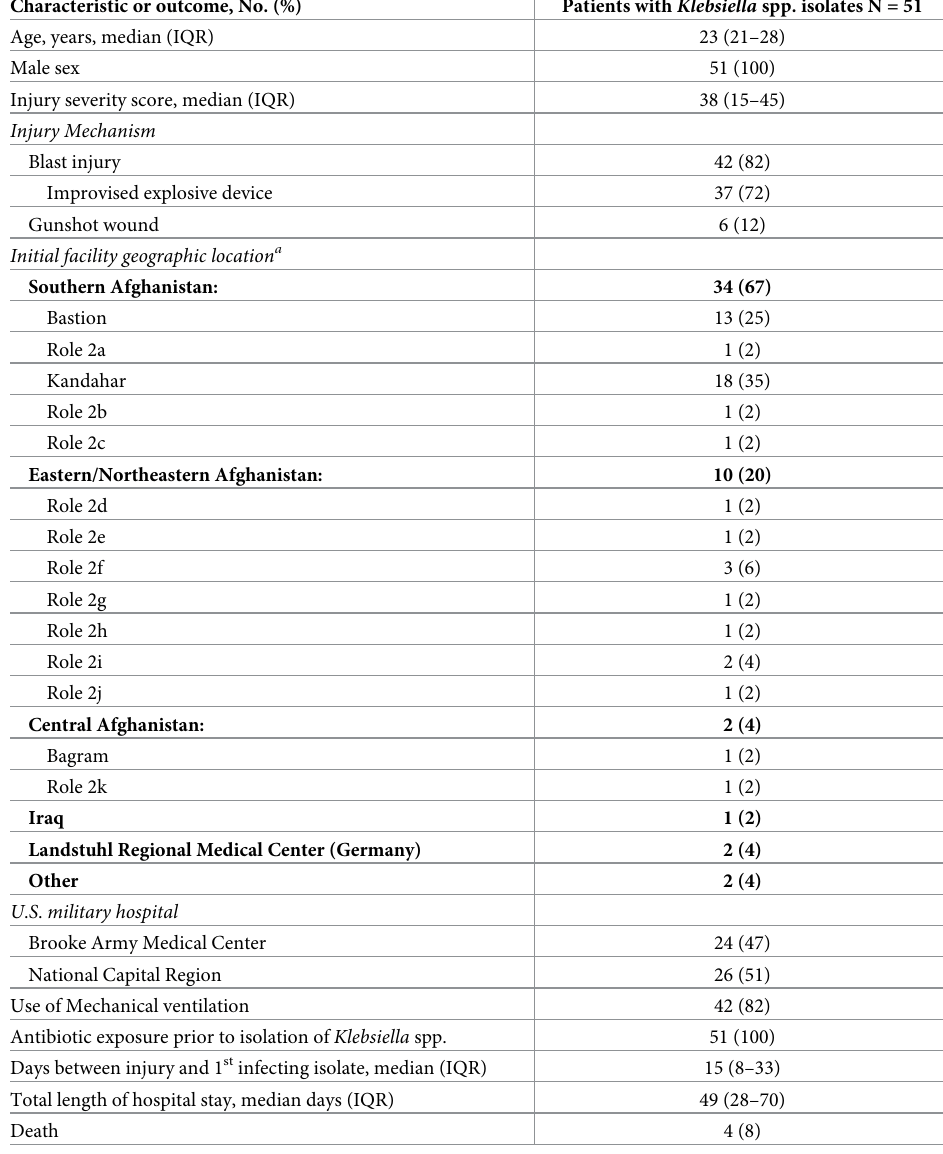
Table 1. Characteristics of patients with Klebsiella species infections. Characteristic or outcome, No.